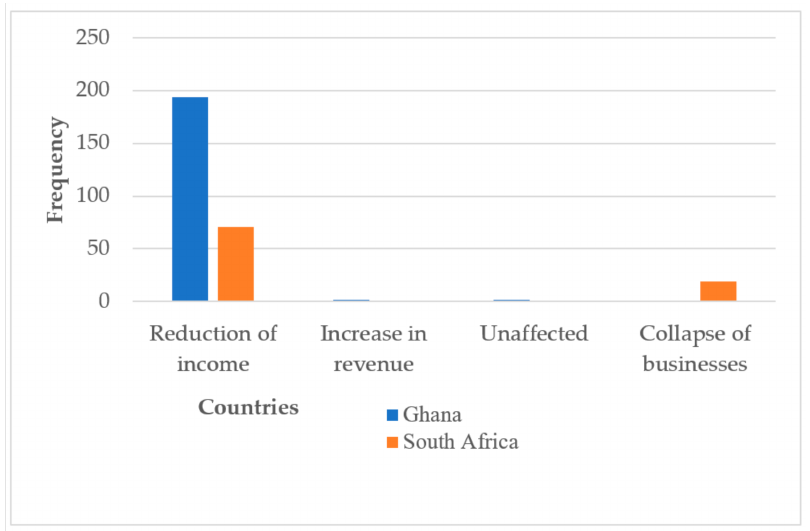
Figure 1. Market women’s general view about the impact of COVID-19 on their businesses.